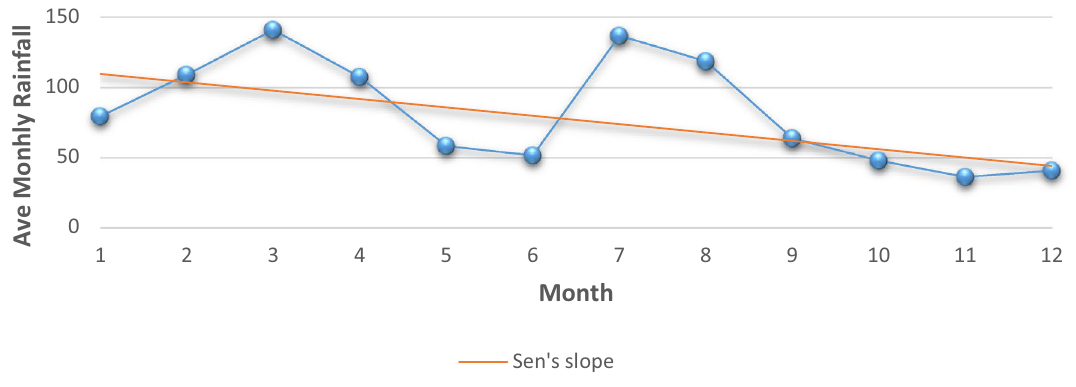
Fig. 7 A plot of average monthly rainfall for Saidu Sharif station. Data Source : Pakistan Meteorological Department and Regional Meteoro- logical